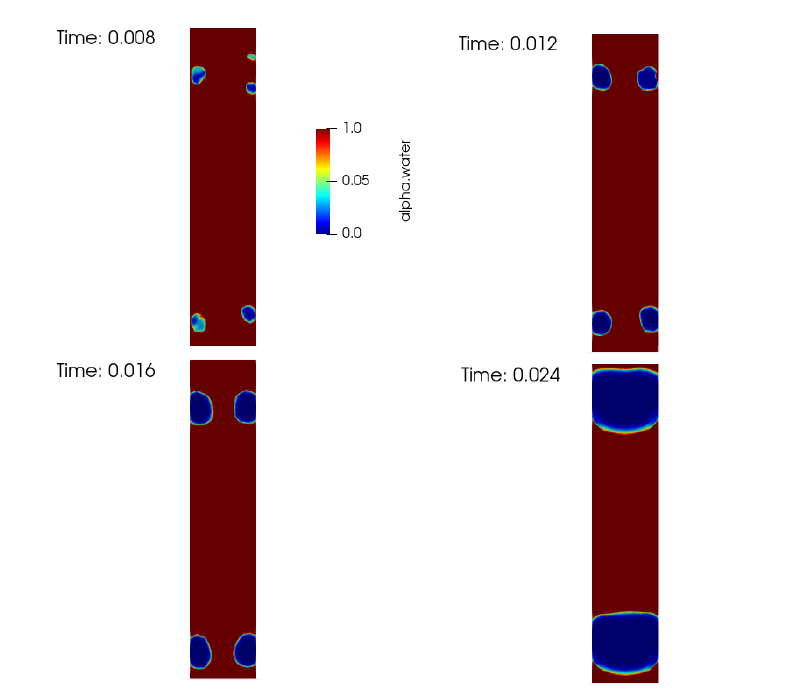
Figure 12. The distribution of ethanol volume fraction (alpha.water) in the evaporator area for the first milliseconds of simulation in the Lee [27] mass transport model for the case of 100 W input power.